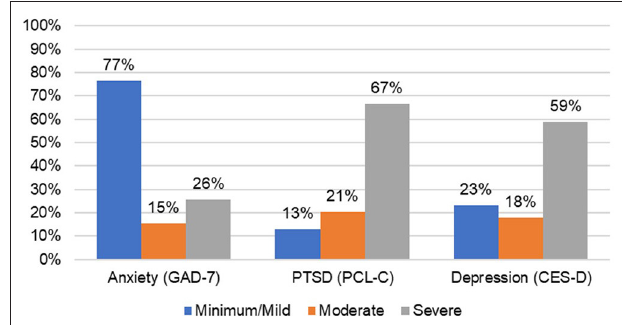
FIGURE 2 | Percent of participants in symptom severity categories at baseline.